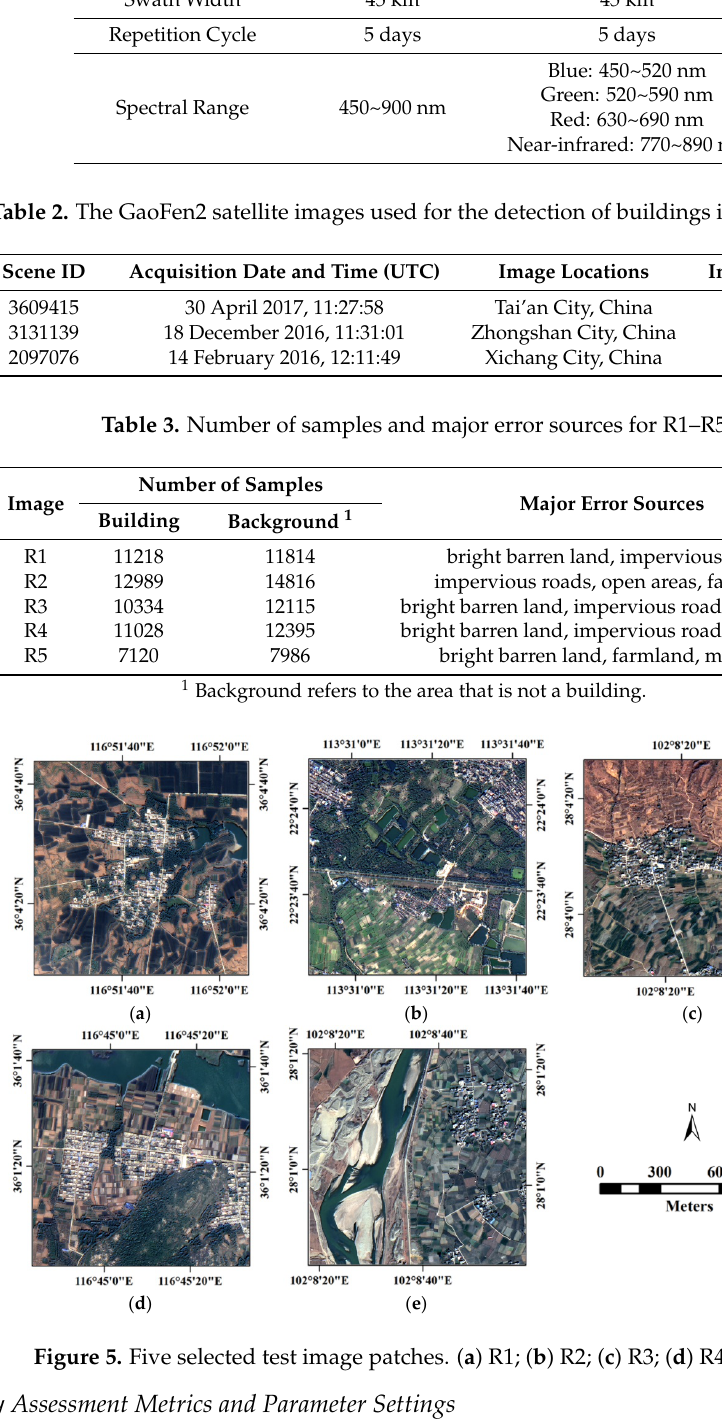
Table 1. The main characteristics of the GaoFen2 satellite.